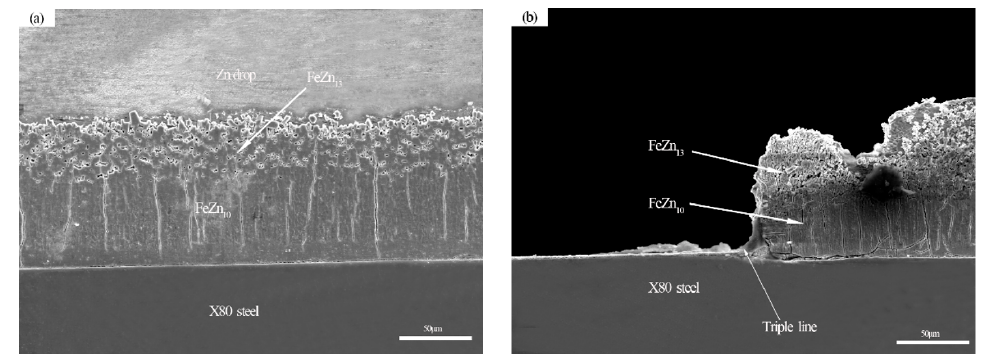
Figure 4. Micro-morphology of the reaction layer at the interface of Zn/X80 steel: ( a ) central reaction layer; ( b ) triple line reaction layer.